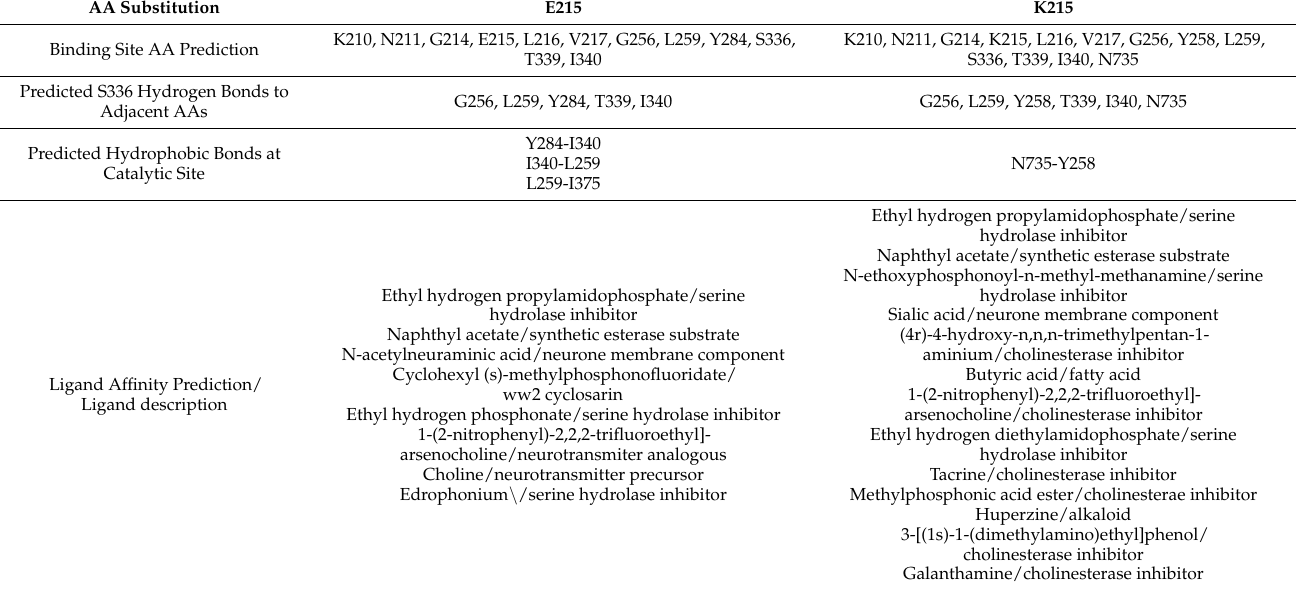
Figure 3. Close ‐ up of the catalytic site 3D structure identified in CestB amino acid sequence. The S336 was identified as the catalytic serine within the active site and different configurations are de ‐ tected by the two different alleles originated by substitution of amino acid 215, which according to the models, are not in close proximity to the catalytic Serine 336 and out of the structure shown in the figure; nevertheless, this substitution induces a structural reconfiguration at the core of the cat ‐ alytic site, notably, the absence of the hydrogen bond interaction between N735 and the catalytic S336. The adjacent T339 in allele K215 (red arrow) is partially displaced by I375 and in the context of this allele only interacts with L259 but not with S336 (red arrow). ANA ligand (Lig) was used to locate the position of the catalytic serine within the active site.